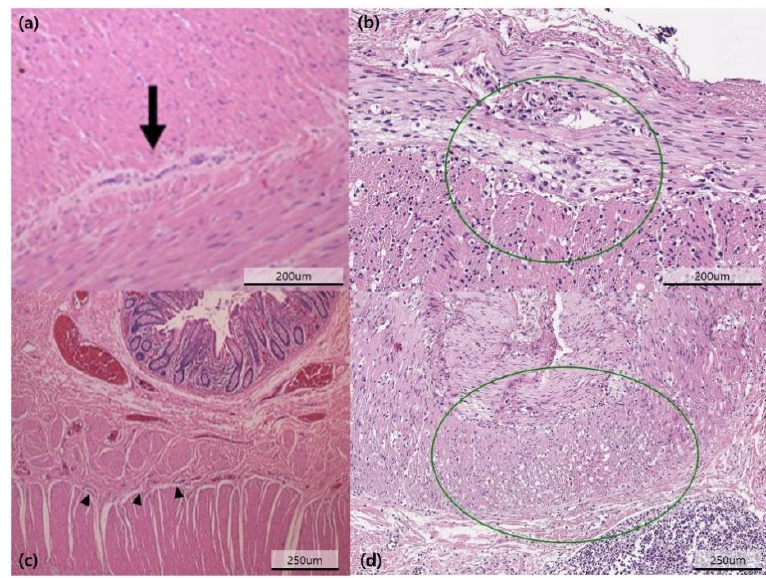
Figure 2. Pathologic specimens in chronic intestinal pseudo-obstruction patients were shown. He- matoxylin and eosin staining shows a hypoganglionosis. Arrow indicated the ganglion in the myenteric plexus ( a ); other slide demonstrates an immature ganglion cell (black triangle) ( b ); additional muscle layer was identified (circle) ( c ); muscle cells in the inner circular muscle layer show vacuolization (circle) ( d ).